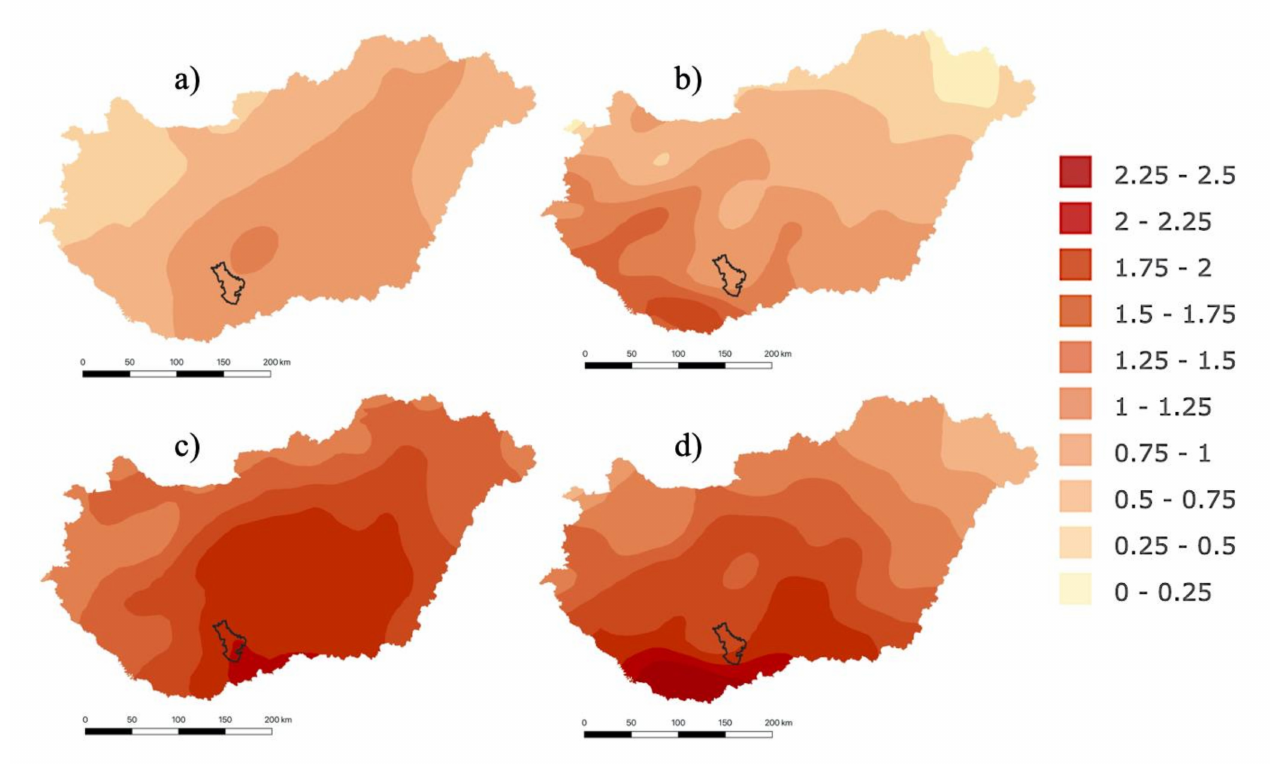
Figure 7. Change of PaDI 0 for the period 2021-2050 and 2071-2100. ( a , b ) Refer to the period of 2021-2050, while ( c , d ) illustrate the change of PaDI 0 for the period 2071-2100. Outputs of the RegCM model were applied to develop ( a , c ). Moreover, results of the ALADIN-Climate regional model were the inputs to create ( b , d